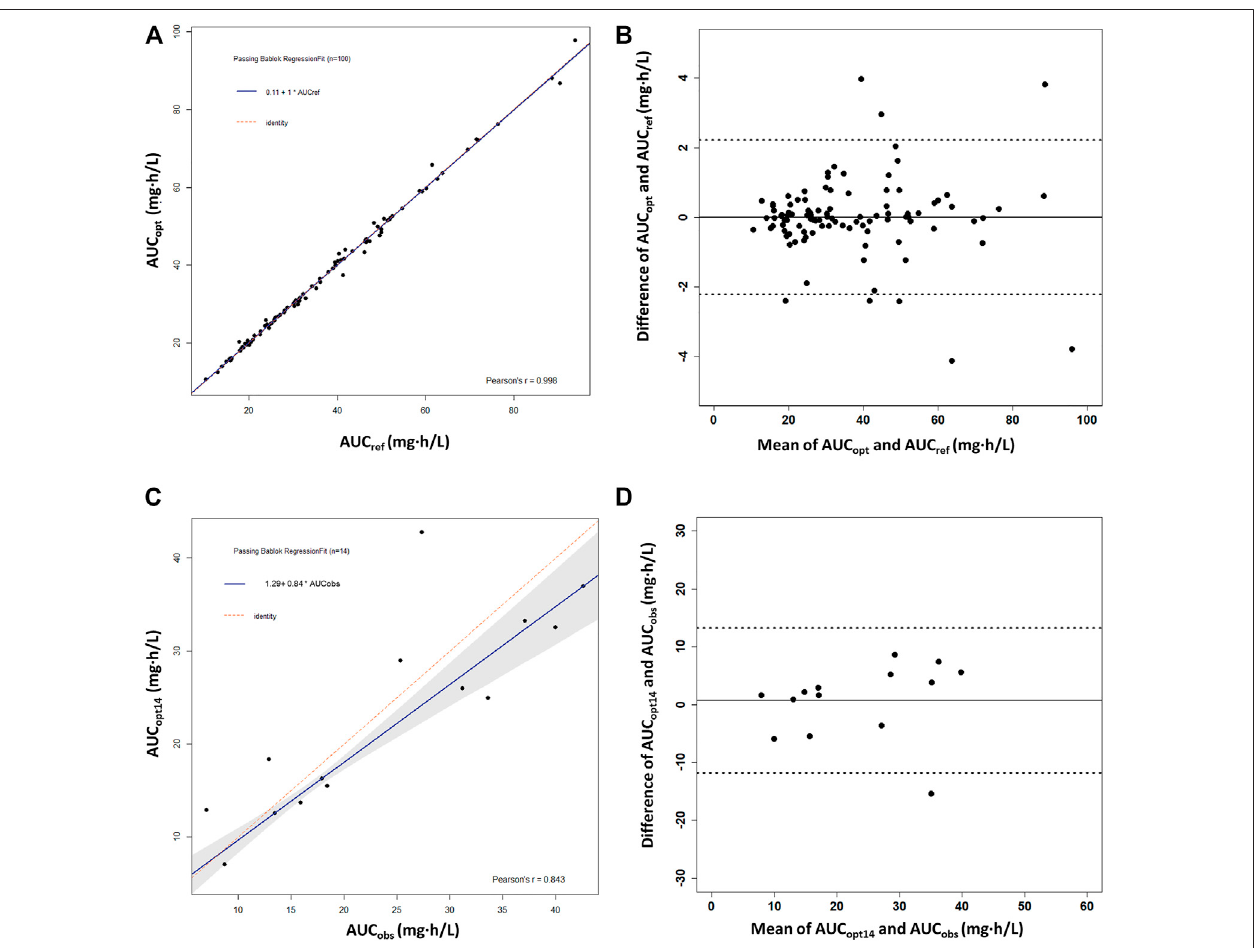
FIGURE 4 | Passing – Bablok regression analysis and the Bland – Altman plot between the reference AUC 0 – 12h and the predicted AUC 0 – 12h of MPA obtained using the optimal sampling times by maximum a posteriori Bayesian (MAPB) estimation in heart transplant recipients. (A,B) Comparison between AUC 0 – 12h based on the full PKpro fi lesofthevirtualpatients(AUC ref )andAUC 0 – 12h basedontheoptimalsamplingtimes(AUC opt )( n (cid:1) 100). (C,D) ComparisonbetweentheobservedAUC 0 – 12h from the patients with intensive data as the reference AUC 0 – 12h (AUC obs ) and AUC 0 – 12h based on the optimal sampling times (AUC opt14 ) ( n (cid:1) 14). AUC 0 – 12h , the area under the curve of the dosing interval; MPA, mycophenolic